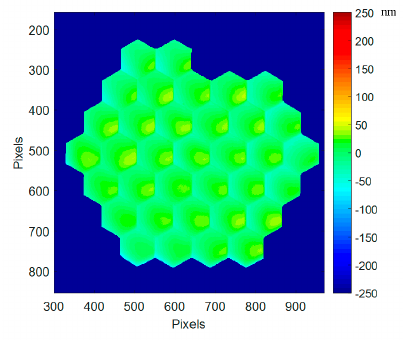
Figure 9. Best flat surface deformation at ambient (17 nm RMS, 123 nm PtV) when the best flat condition calibrated by Iris AO is applied; the gravity effect has not been removed.